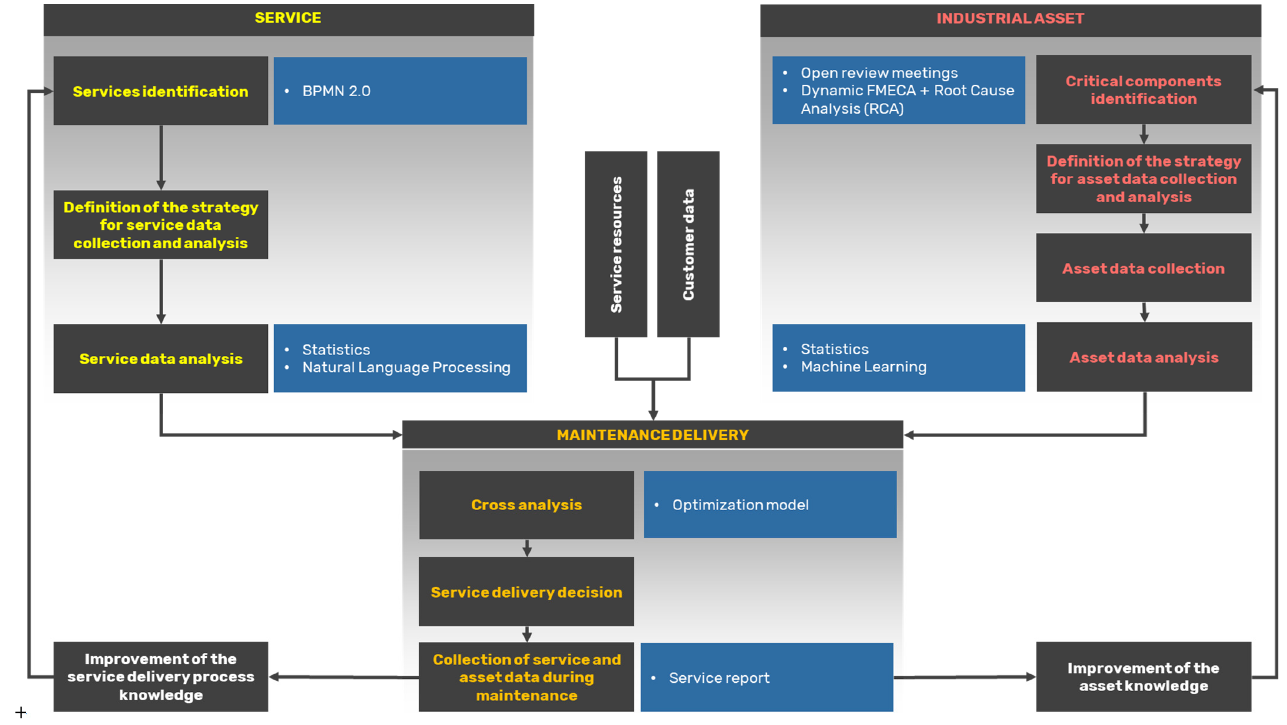
Figure 1. The D3M framework [10].